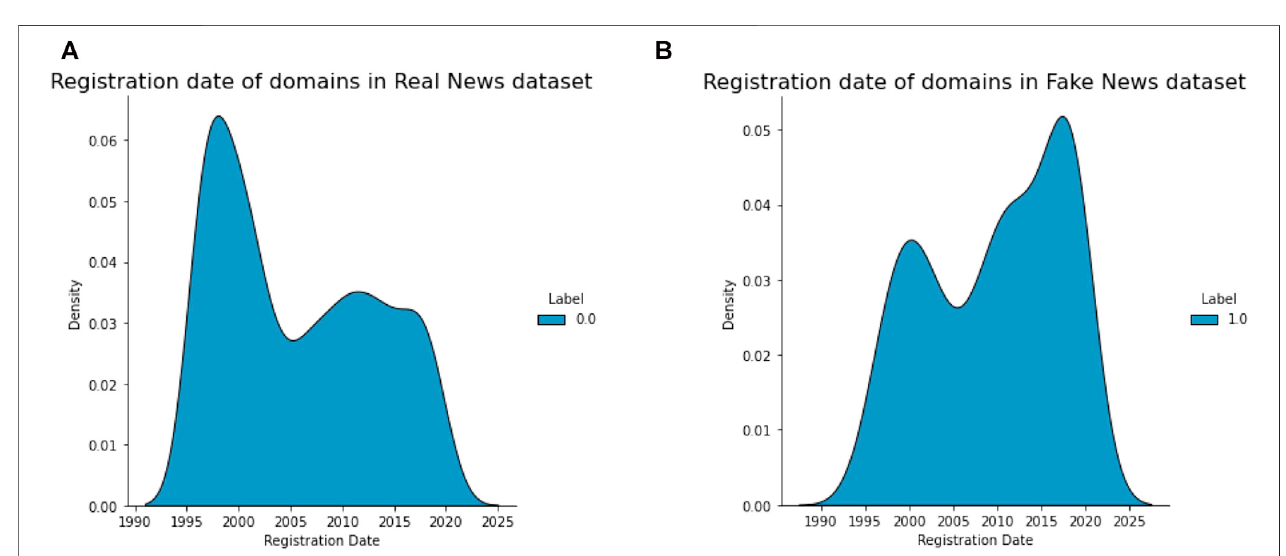
FIGURE 6 | Density distribution of domain name ’ s age by class. The resulting distributions show a very clear negative skew (B) versus a positive skew (A) . Age of domain can be extracted from Wayback or WHOIS external services. Based on the analysis, we observed that fake news or misleading content is published or shared more likely by newer